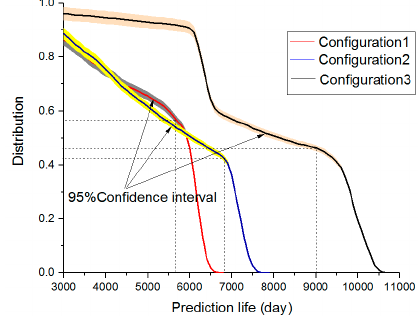
Figure 18. Life distribution with different configurations under work mode M1.